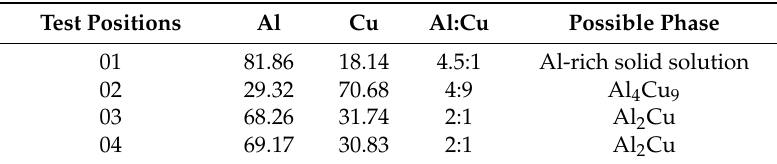
Table 1. EDS point analysis results of the location in Figure 2 (at